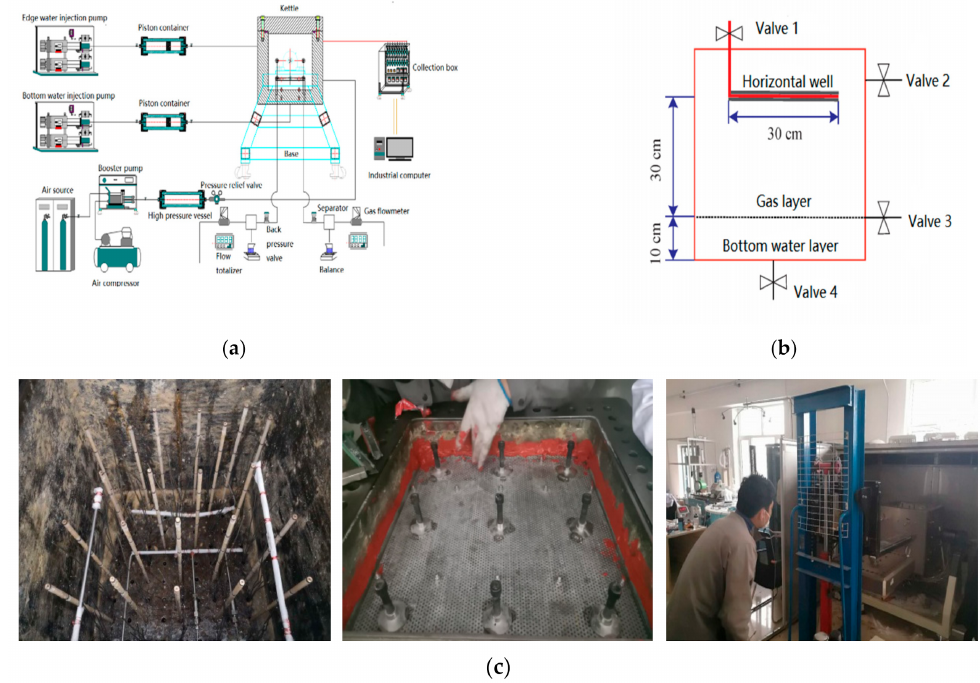
Figure 7. Water invasion simulation experiment device diagram of large 3D bottom-water gas reservoir: ( a ) Connection flow chart of experimental equipment, ( b ) front view of main kettle body and ( c ) physical drawing of experimental